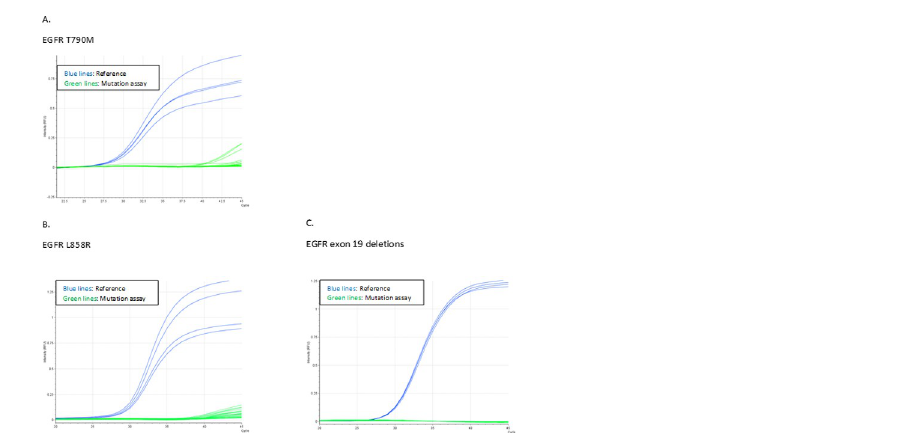
Fig 5. Test of LoB. Graphs describing the LoB evaluation based on the characterization of repeated testing of cfDNA pooled from 58 healthy donors A. Curves representing the T790M LoB results. B. Curves representing the L858R LoB results. C. Curves representing the EGFR exon 19 deletion LoB